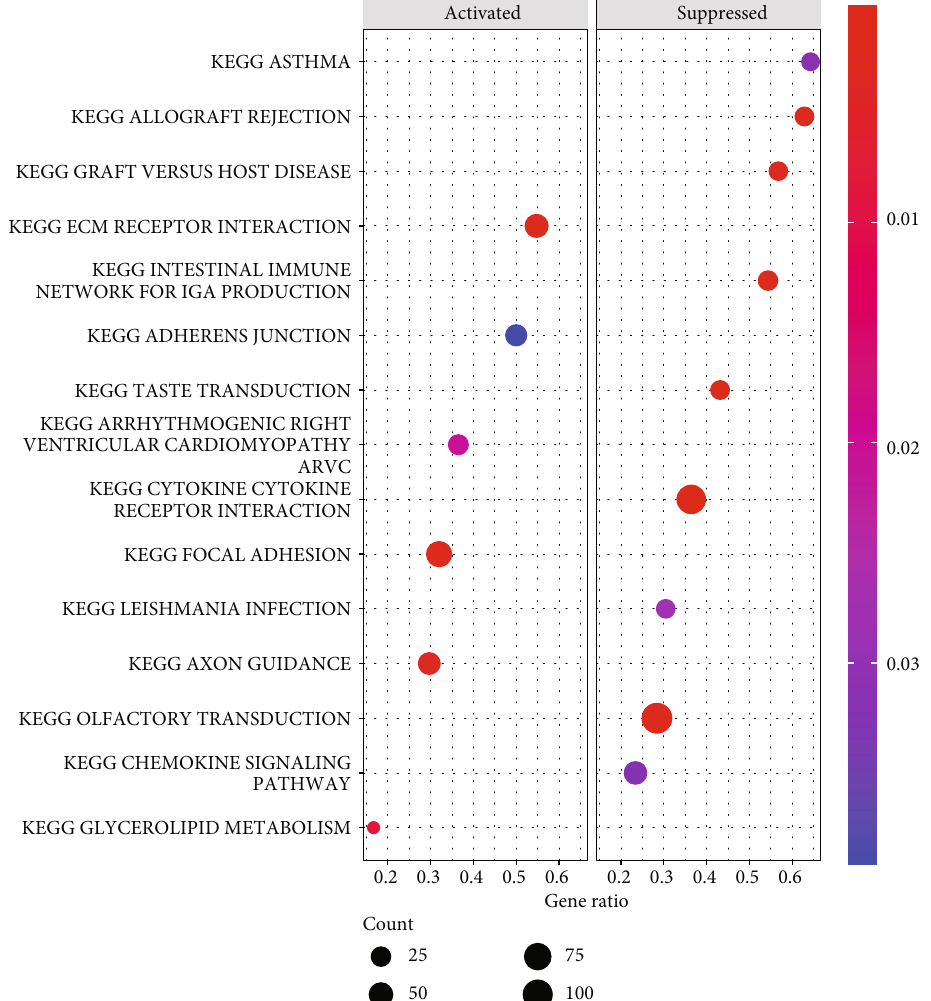
Figure 5: GSEA analysis between patients with high-risk and low-risk